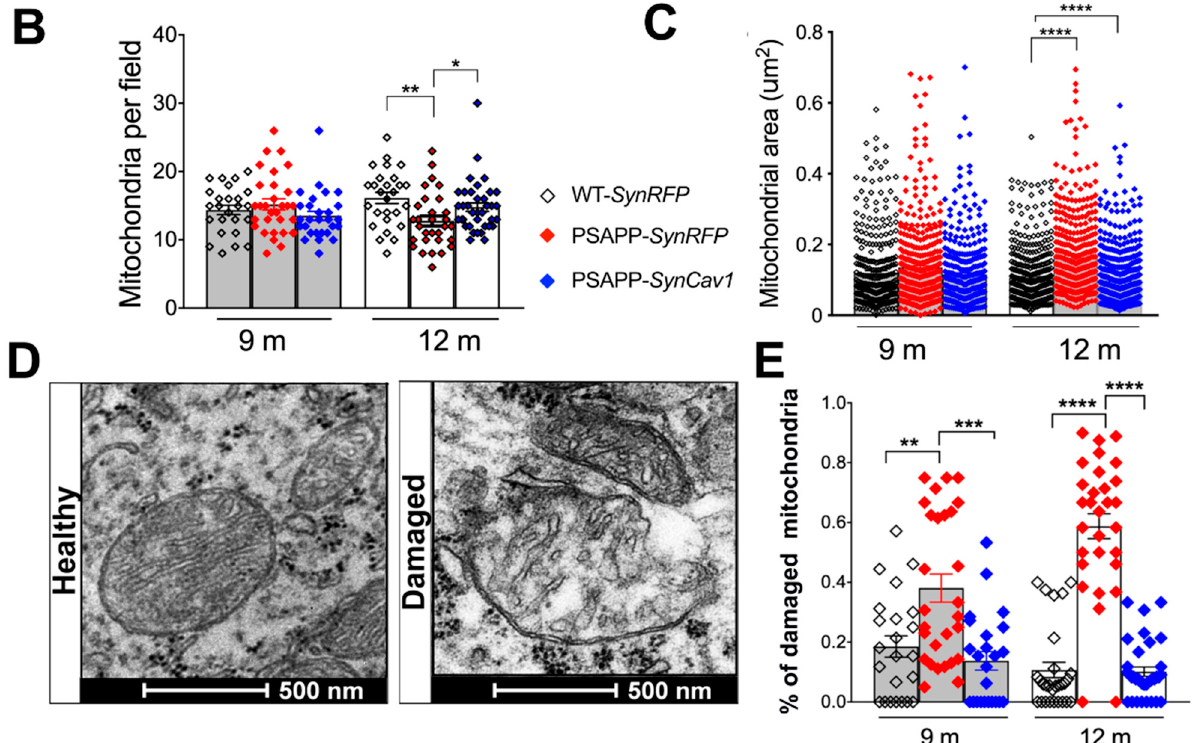
Figure 2. PSAPP- SynRFP mice exhibit less soma mitochondria with larger area, while PSAPP- SynCav1 shows a similar mitochondria profile as WT- SynRFP . ( A ) EM images of CA1 molecular cell layer consisting of pyramidal cell bodies in 12 m mice. The red arrow indicates damaged mitochondria with disrupted cristae and empty vacuoles. Quantitation of mitochondrial count and area ( B , C ). Representative EM image and quantification of damaged mitochondria ( D , E ). Data are presented as mean ± S.E.M., n = 5 animals per group with 8–12 micrographs per animal. Data were analyzed using One-Way ANOVA. Significance was assumed when p < 0.05. * p < 0.05, ** p < 0.01, *** p < 0.001, **** p < 0.0001.